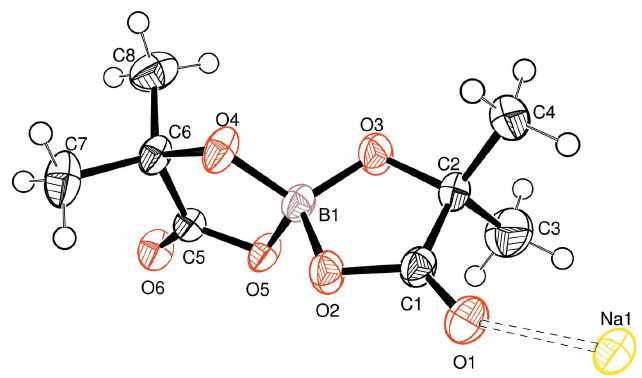
Figure 1 A view of the asymmetric unit of the title compound showing the atom numbering with displacement ellipsoids drawn at the 50% probability level.